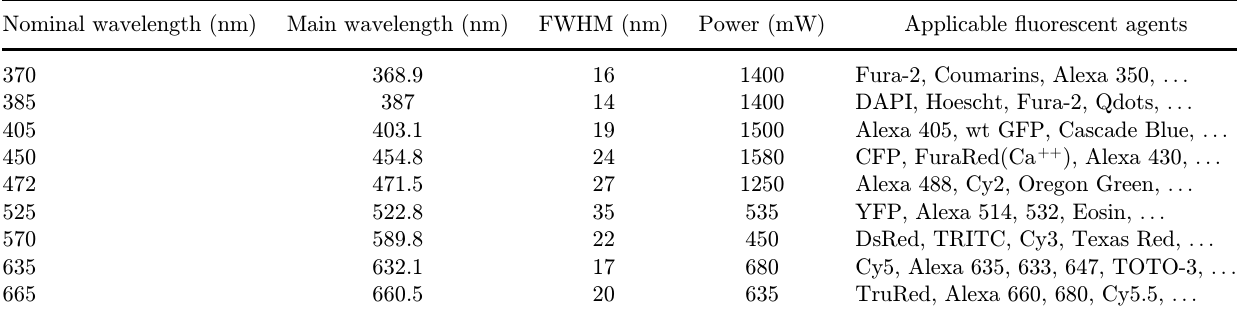
Table 1. Wavelengths of the self-developed multi-wavelength LED array and the corresponding °uorescent agents. Nominal wavelength (nm)